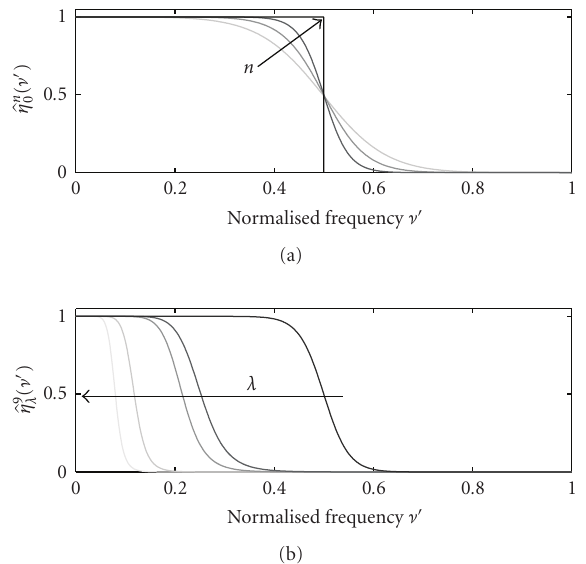
Figure 3: Frequency response of the polynomial spline filter η n (a) λ = 0 and orders n = 3, 5 and 9 (black arrow indicates increasing order). (b) n = 9 and λ = 0,0 . 01,0 . 05,20 and 1000 (black arrow indicates increasing value of λ ). Frequency ν (cid:2) is normalized by the sampling frequency.